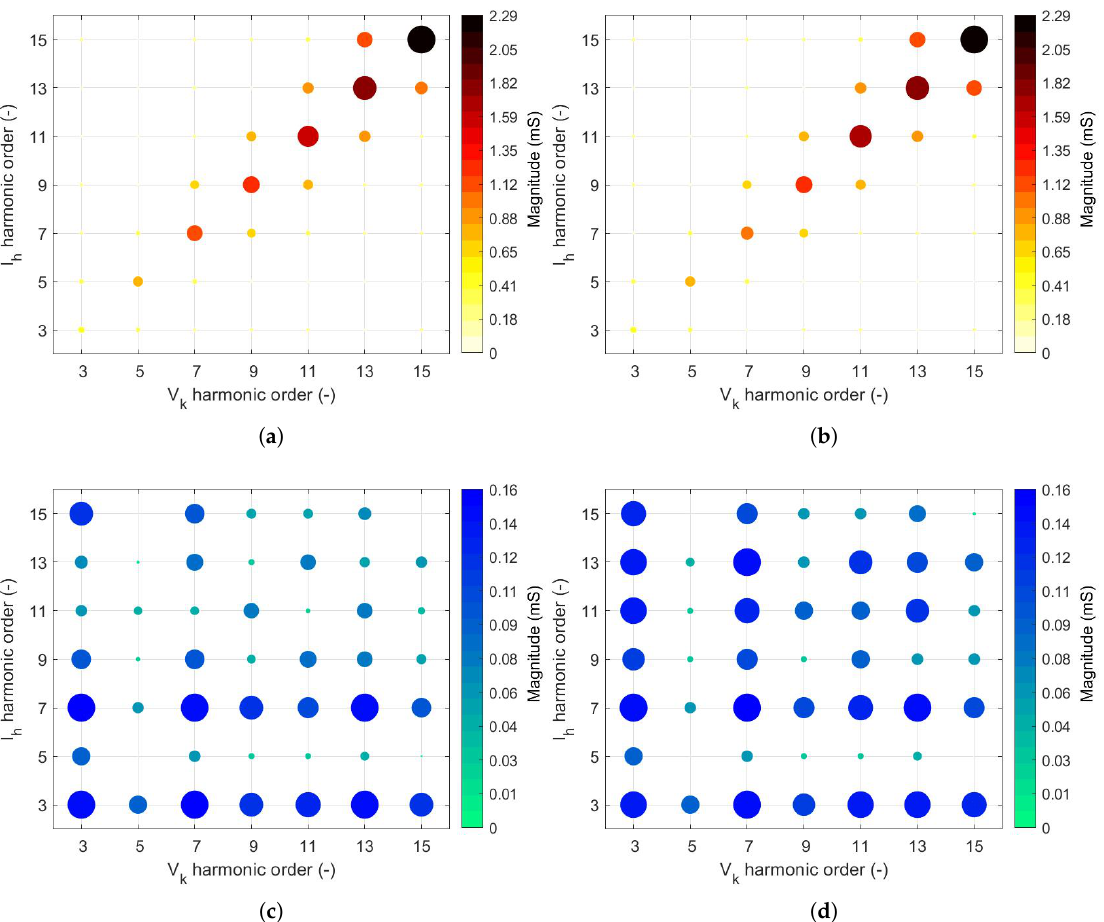
Figure 14. Magnitude of frequency coupling matrices of the Type B LED lamp: ( a ) Y + FT; ( b ) Y + PT; ( c ) Y − FT; and ( d ) Y −